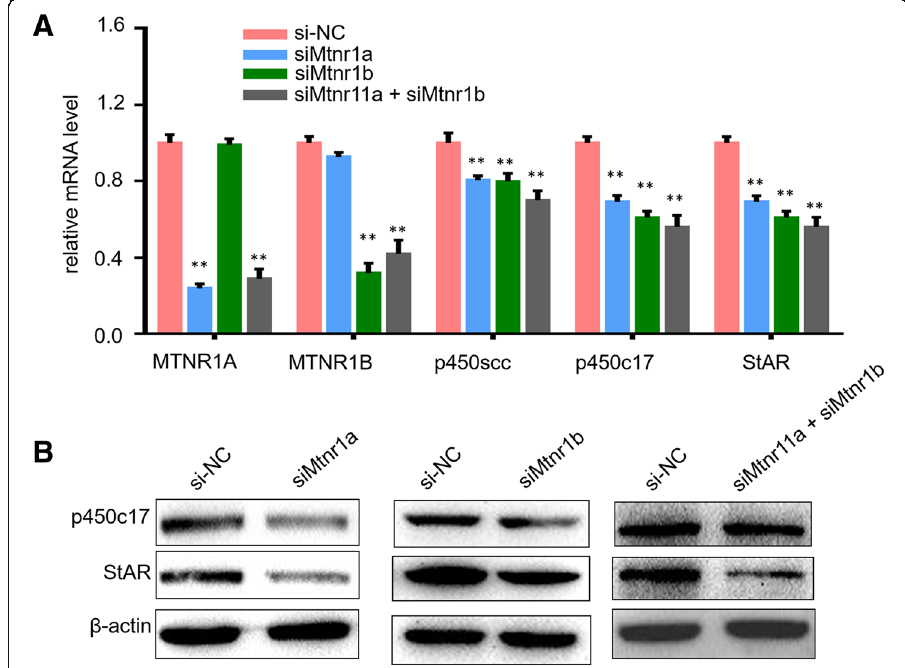
Fig. 4 MTNR1A and MTNR1B regulated steroidogenic gene expression in mLTC-1 cells. a . mLTC-1 cells after transfection of si-Mtnr1a and si-Mtnr1b were treated with 1 IU/ml hCG for 6 h before monitoring of mRNA expression levels of p450scc, P450c17 and StAR using qPCR assay. b . Western blotting results of p450c17 and StAR protein expression in mLTC-1 after knockdown of MTNR1A and MTNR1B using specific